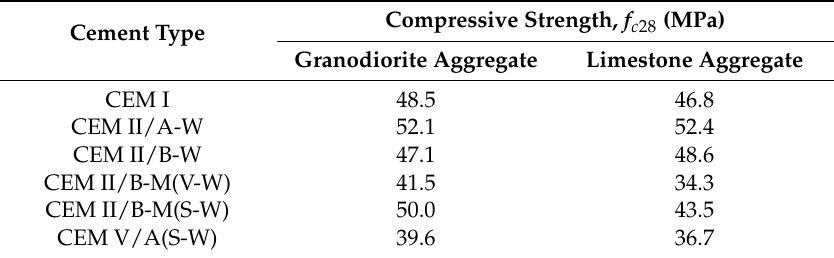
Table 4. Concrete compressive strength after 28-days of curing (average values of three